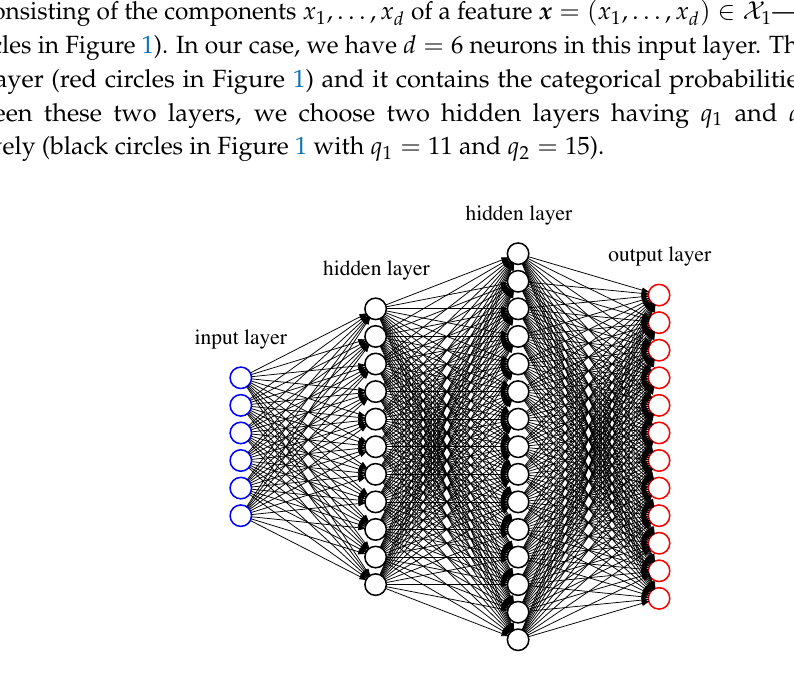
Figure 1. Deep neural network with two hidden layers: the first column (blue circles) illustrates the d = 6 dimensional feature vector x (input layer), the second column gives the first hidden layer with q 1 = 11 neurons, the third column gives the second hidden layer with q 2 = 15 neurons and the fourth column gives the output layer (red circle) with 12